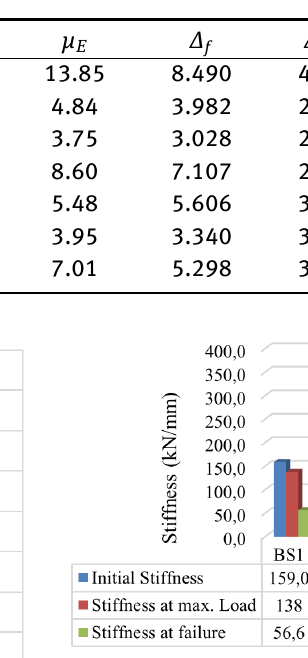
Table 5: Ductility index and Deferability factor